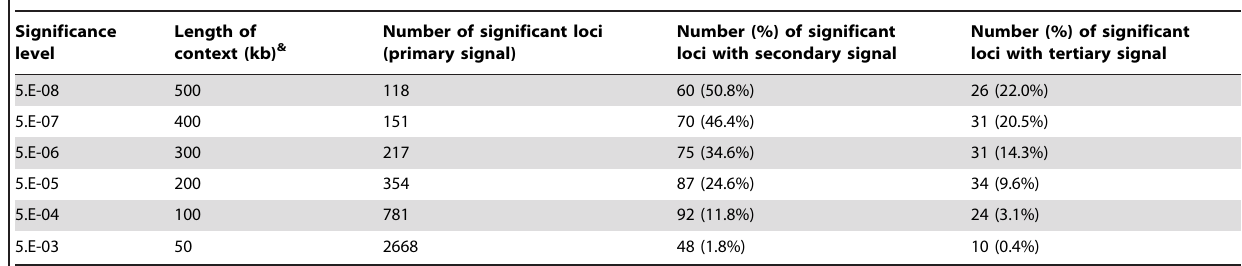
Table 1. Numbers of significant loci and conditional